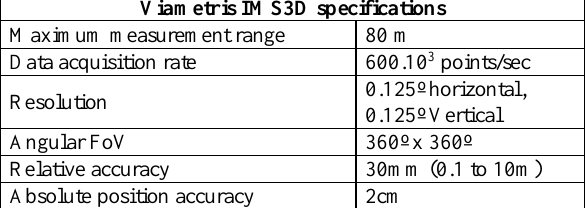
Table 1. Technical characteristics of the Viametris IMS3D